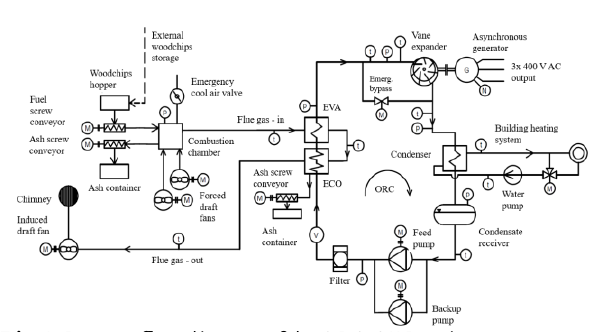
Fig. 1. Process flow diagram of the ORC CHP unit.